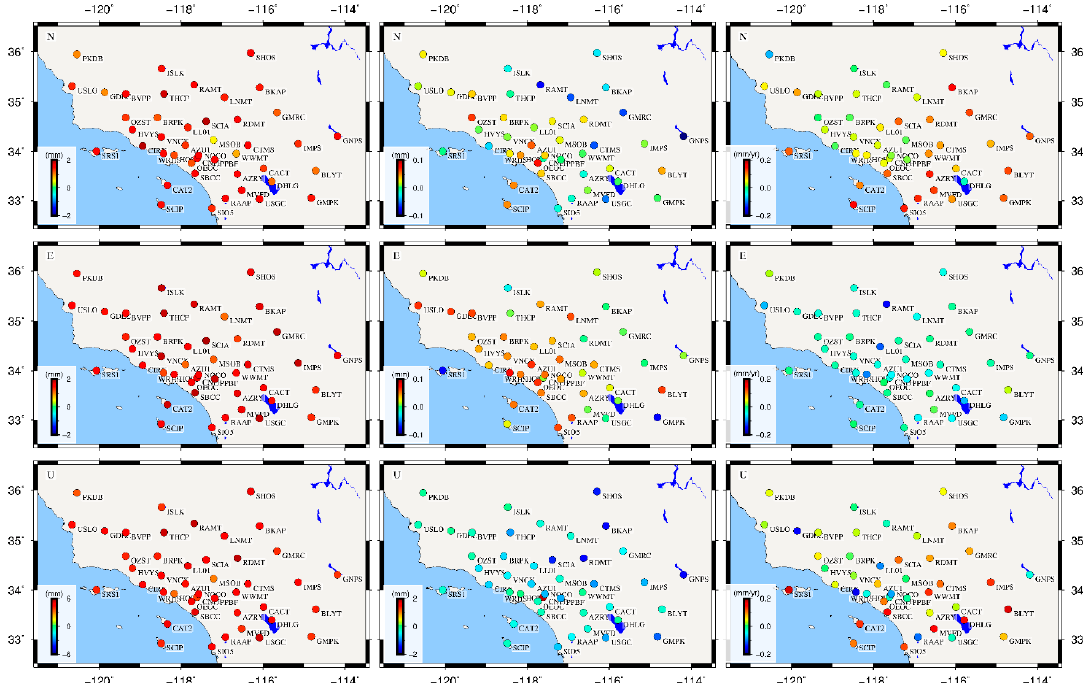
Figure 8. The variation of amplitudes of PLN (left panels) and WN (middle panels) before and after CME filtering with VBPCA, together with the velocity differences (right panels). From top to bottom panels represent the North, East and Up components. Sensors 2020 , 20 , x FOR PEER REVIEW